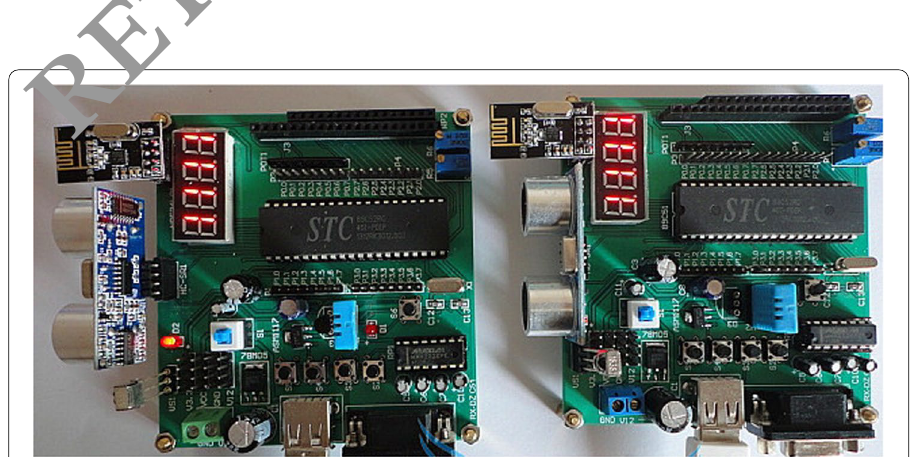
Fig. 2 Physical map of wireless sensor (Picture is from Baidu